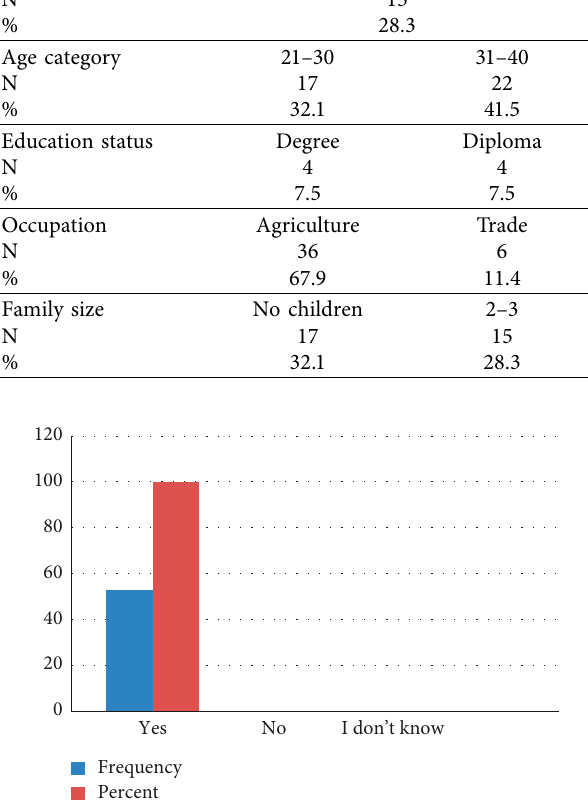
Figure 3: Presence of HWC in the study